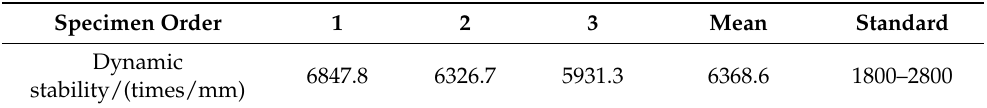
Table 11. Dynamic stability of asphalt mixture.